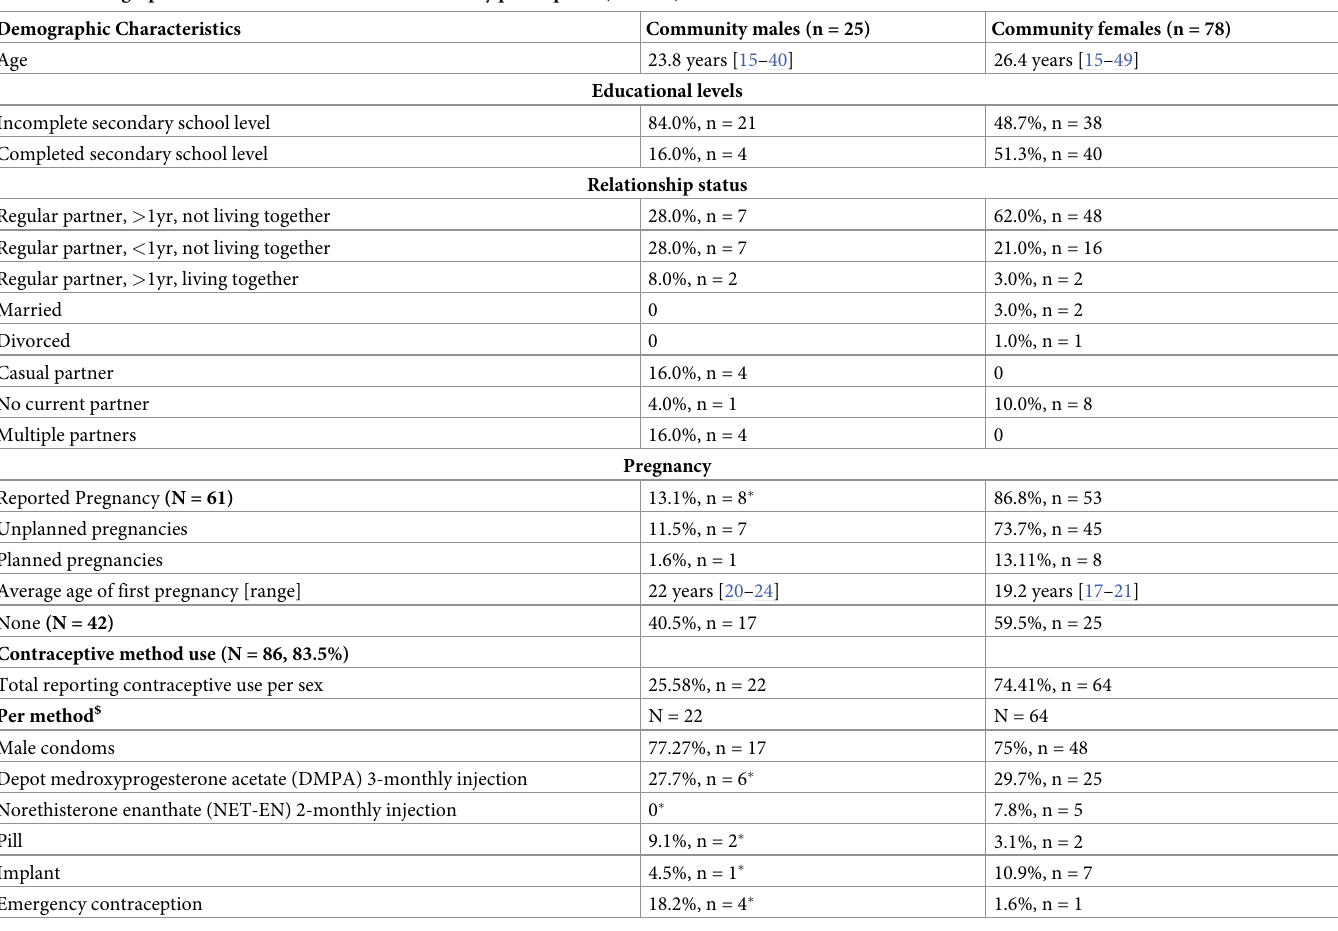
Table 1. Demographic data for male and female community participants (N =